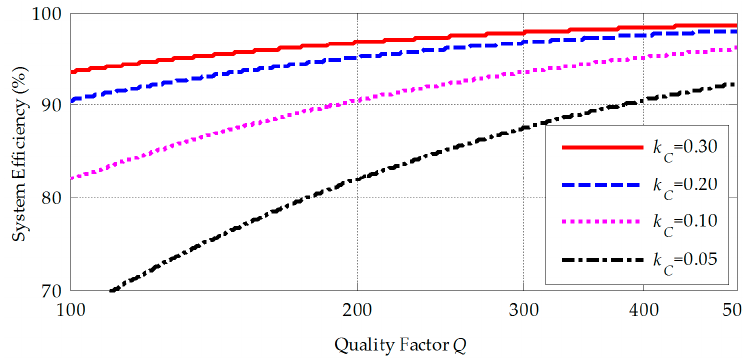
Figure 12. Maximum achievable efficiency of a CPT system at different values of k C and Q .